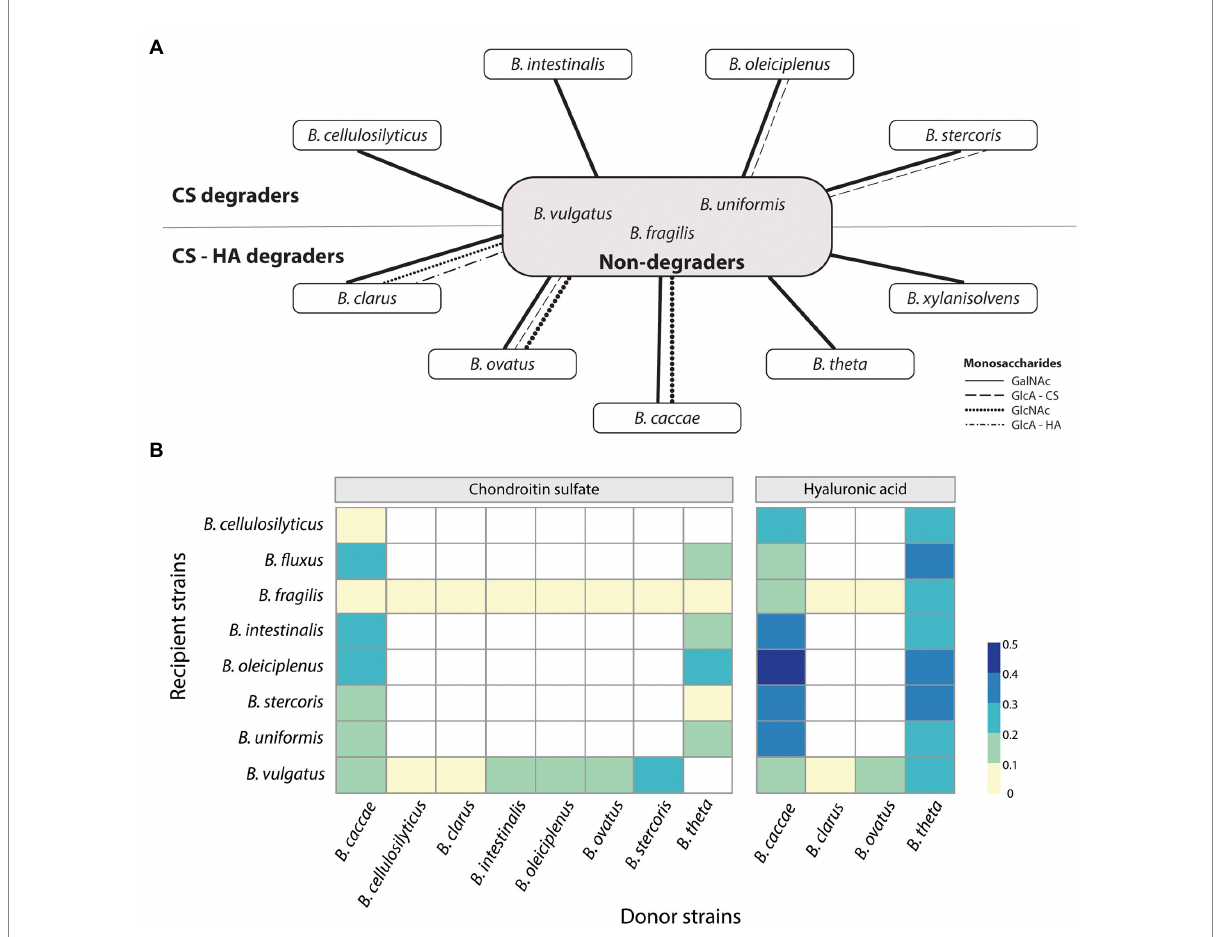
FIGURE 4 Sharing of public goods depends on carbon source and donor and recipient strains. (A) Theoretical public goods provision by CS and CS-HA degraders to non-degraders based on fluorophore-assisted carbohydrate electrophoresis results. CS, chondroitin sulfate; HA, hyaluronan; GalNAc, N-Acetylgalactosamine; GlcNAc, N-Acetylglucosamine; GlcA – CS, glucuronic acid from CS; GlcA – HA, glucuronic acid from HA. (B) Not all donor strains (selected CS-HA and CS-only degraders) can supply public goods. Similarly, not all non-degraders are capable of growth on CM. HA donors supply better growth than CS donors. Donor strains were grown until late exponential after which the supernatant was filtered and diluted 1:1 with fresh M9 medium. Recipient strains were then grown on this Conditioned Media (CM) for 20 h. Optical densities (OD) were normalized to the maximum value grown on glucose. OD at 19 h is shown. White boxes indicate N/A